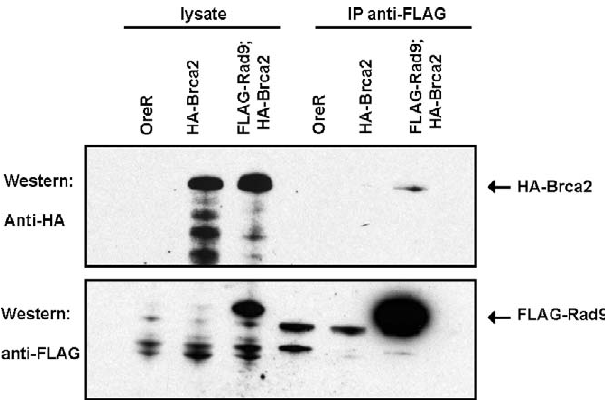
Figure 5. Brca2 Co-Immunoprecipitates with Rad9, a Member of the 9-1- 1 Checkpoint Complex Western blots from FLAG-Rad9 immunoprecipitations probed for FLAG and HA epitopes. Approximately 1/20 of the lysate prior to immuno- precipitation and the entire immunoprecipitated protein fraction was loaded. Ovaries from females carrying single copies of P f UAS-Brca2-HA g and/or P f UAS-FLAG- Rad9 g and the germline driver nanos -Gal4-VP16 were harvested for the